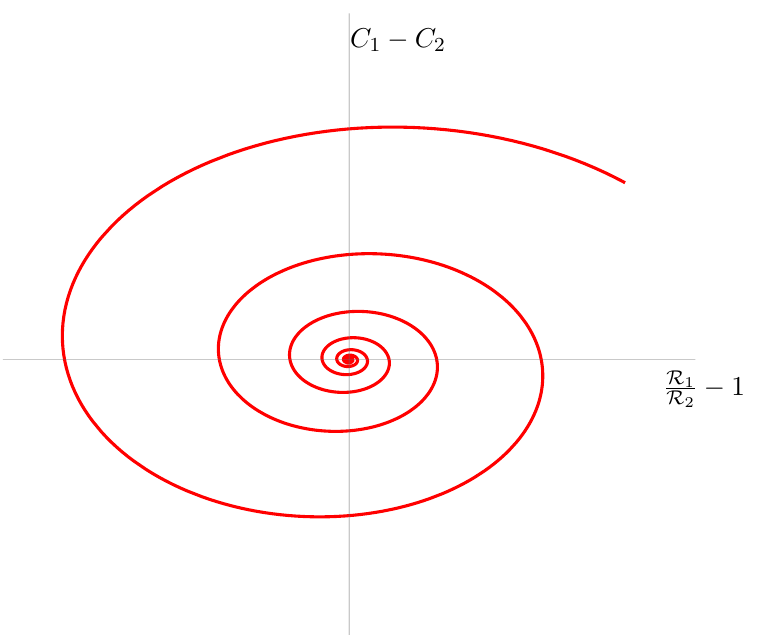
Figure 1 . E(cid:12)mov spiral. Each point on the spiral represents a regular solution with sphere 1 shrinking to zero size and sphere 2 remaining (cid:12)nite in the IR. As we proceed towards the center, the IR radius of sphere 2 becomes smaller and smaller. The origin corresponds to the singular solution, in which both spheres shrink to zero